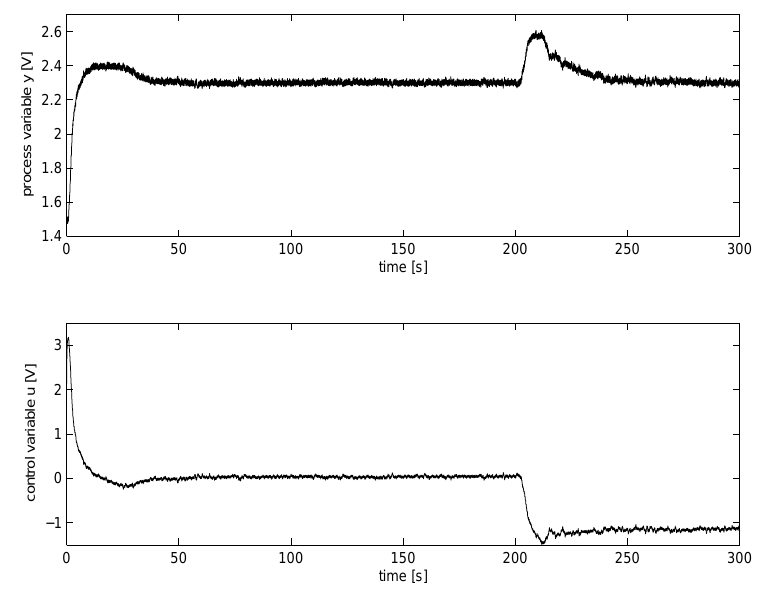
Figure 14. Experimental results for an integral process: after